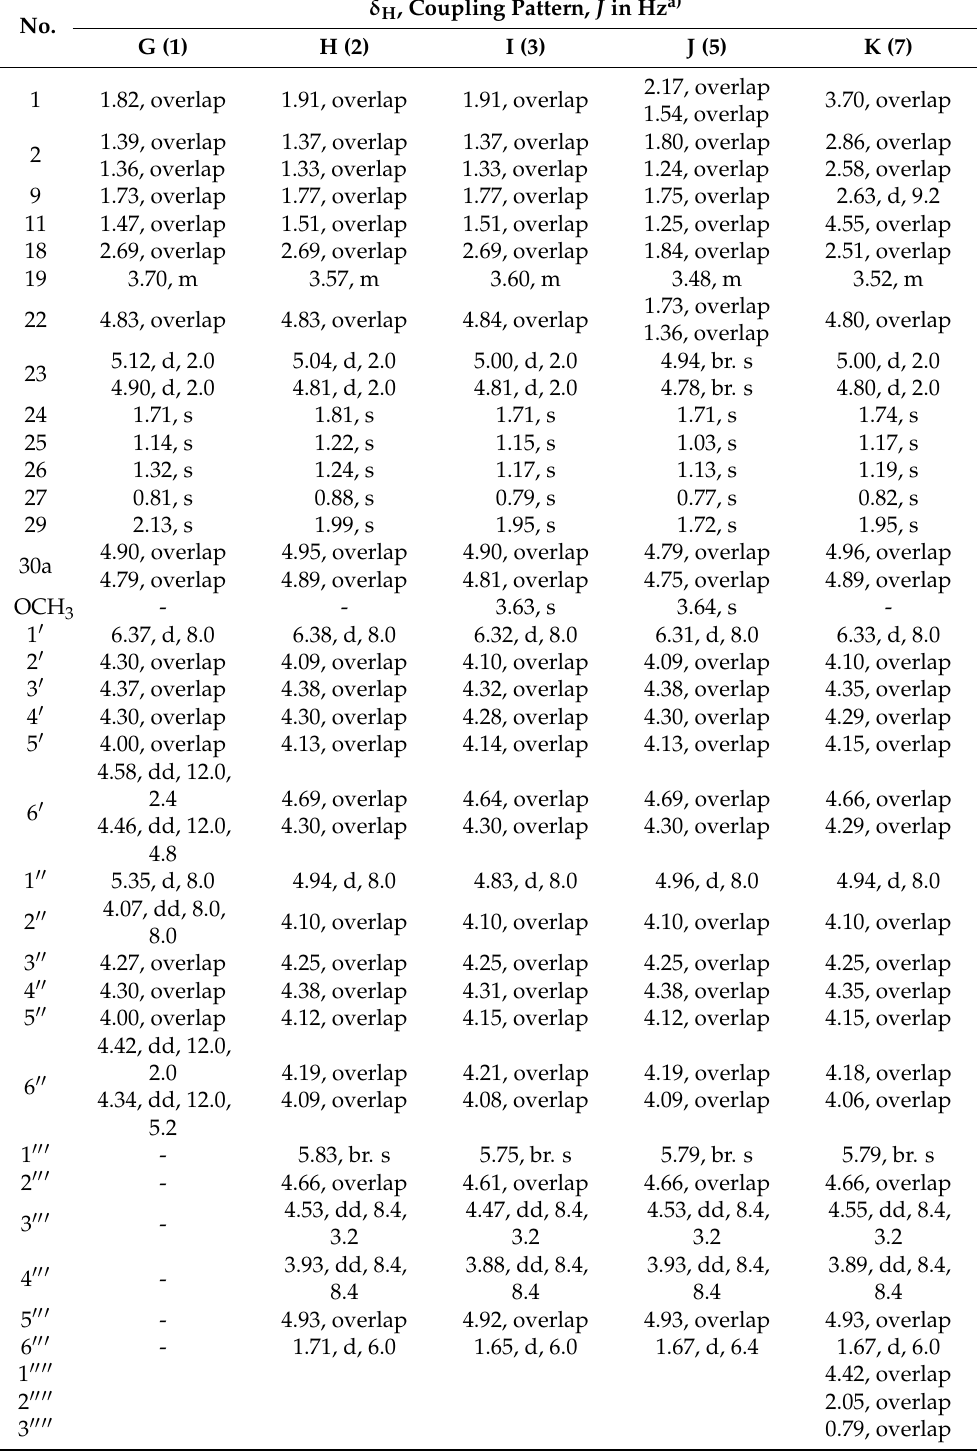
Table 1. 1 H-NMR data of acanthosessilioside